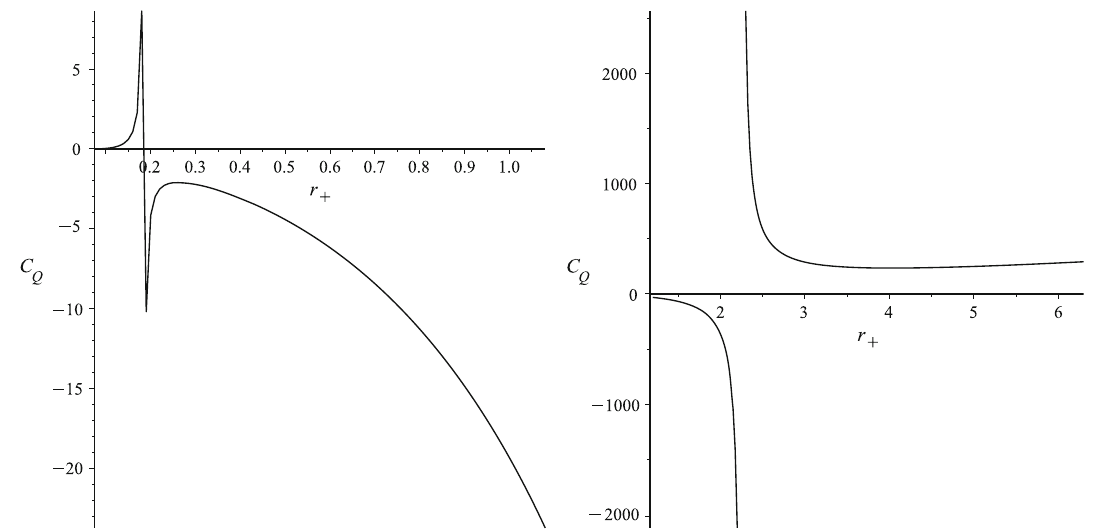
Fig. 4 Heat capacity C Q as a function of horizon radius r + when the other parameters are fixed ( n = 3, α = 0 . 5, b = 1, q = 0 . 1 and (cid:2) = − 1). The left graph represents the heat capacity near the first point of